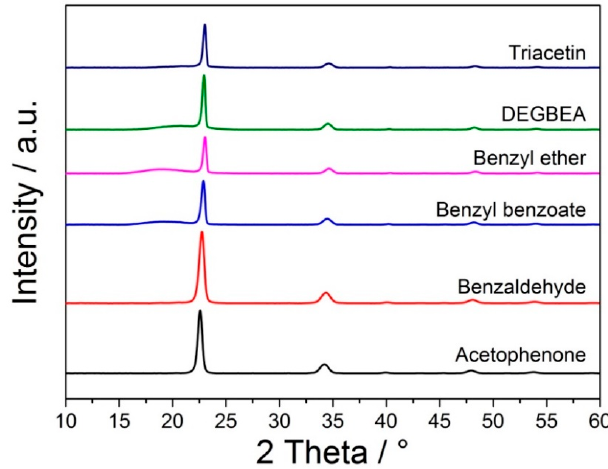
Figure 2. Diffractograms of POM powders precipitated from acetophenone, benzaldehyde, benzyl benzoate, benzyl ether, DEGBEA, and triacetin with an initial POM concentration of 10